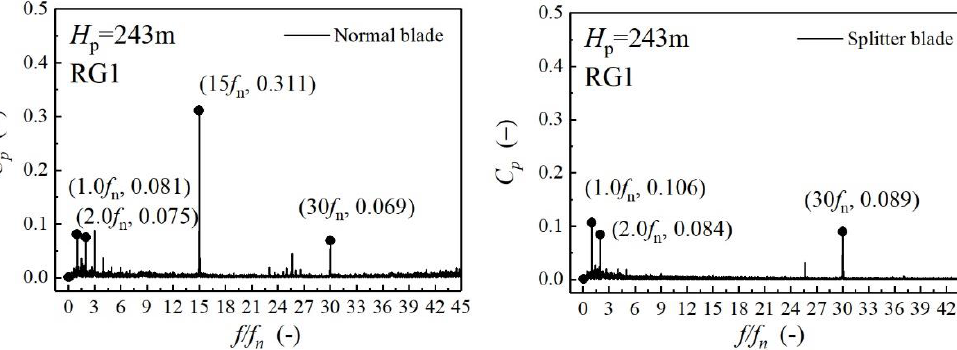
Figure 16. Frequency characteristics in the spiral casing at 243 m head.